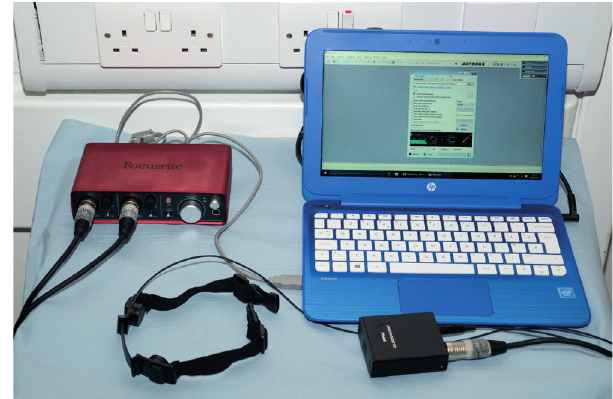
Figure 3. External USB-driven mixer, audio recording software and XLR- connected microphone and